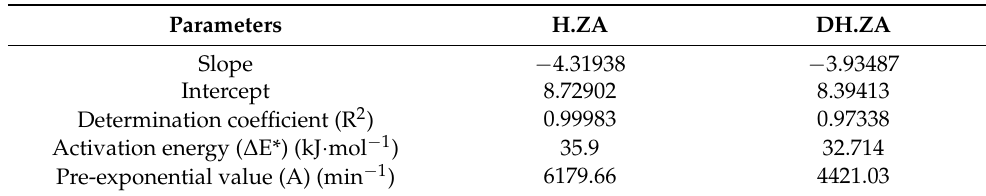
Table 4. The activation energy and pre-exponential values of the transesterification reactions by both H.ZA and DH.ZA according to the Arrhenius equation.